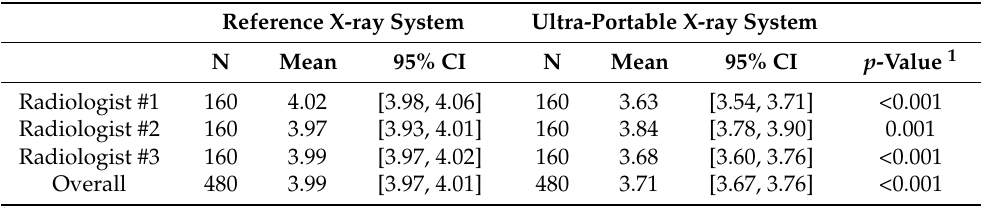
Table 3. Comparison of image quality by a human reader between the reference and ultra-portable X-ray systems at the National Lung